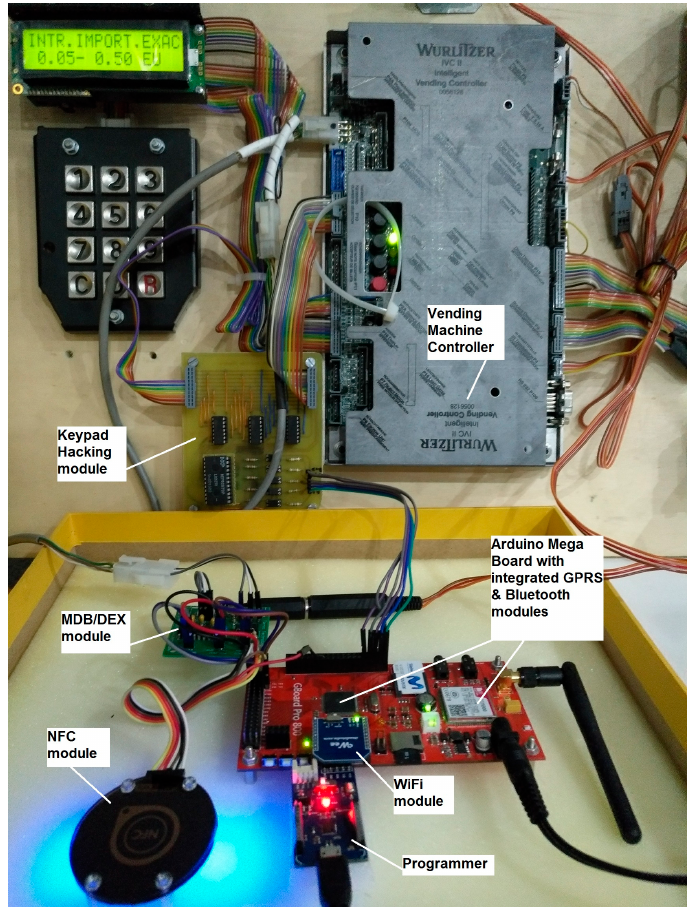
Figure 1. Open hardware prototype.